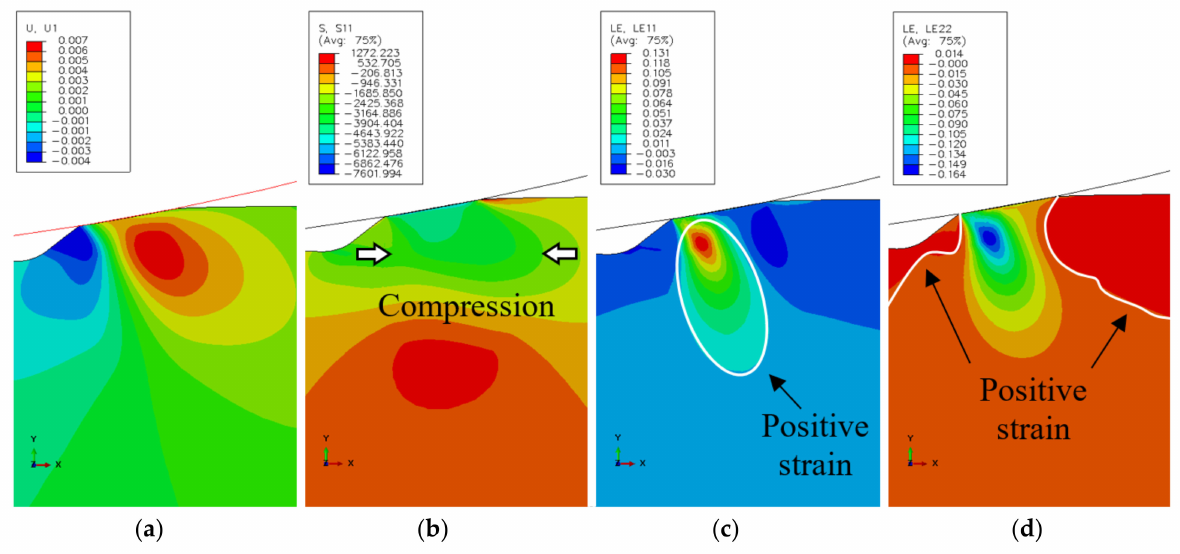
Figure 5. Simulation results of the ( a ) displacements in the horizontal direction x, ( b ) the stress σ xx , ( c ) the strain ε xx and ( d ) the strain ε yy at the maximum normal contact load, F n